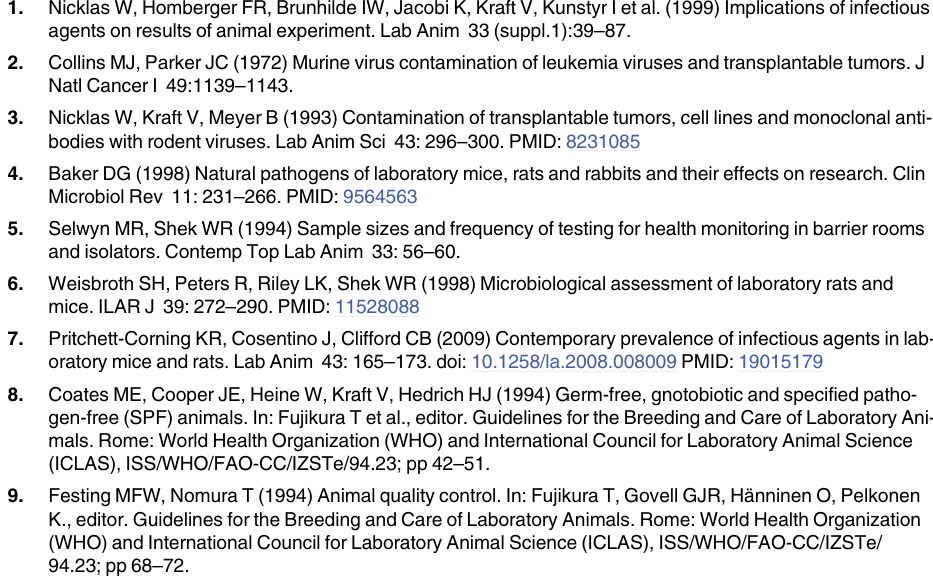
S1 Table. Results for various mice pathogens. Note: OD values > 0.30 were considered as pos- itive as per the instructions by the ELISA kit manufacturer. S2 Table. Results for various rat pathogens. Note: OD values > 0.30 were considered as posi- tive as per the instructions by the ELISA kit